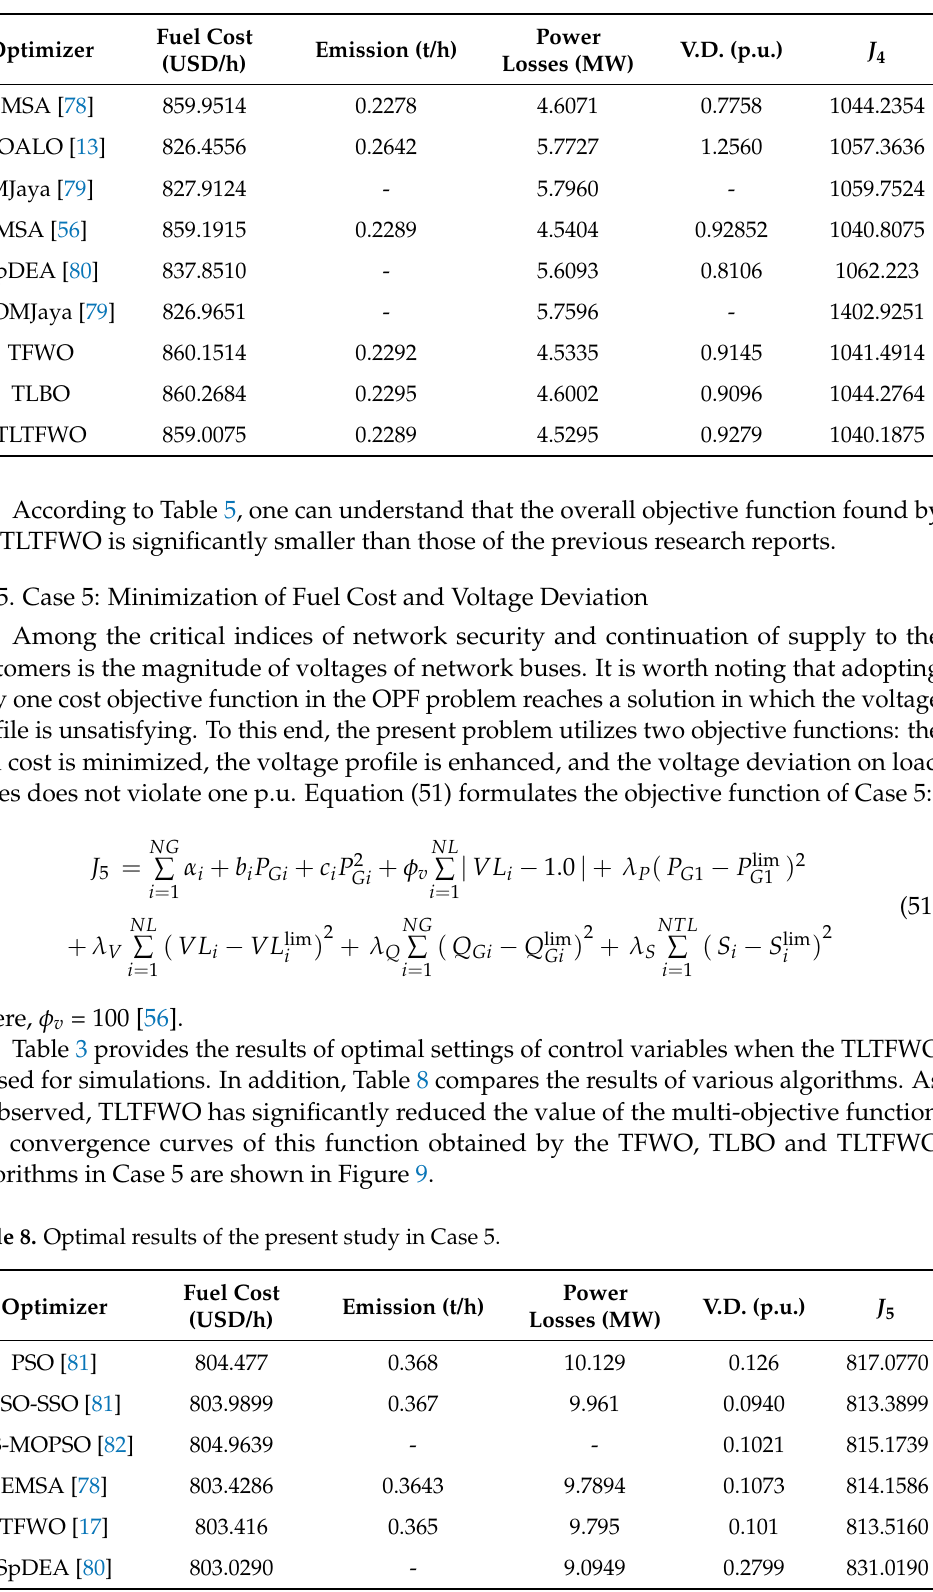
Table 7. Optimal results of the present study in Case 4.